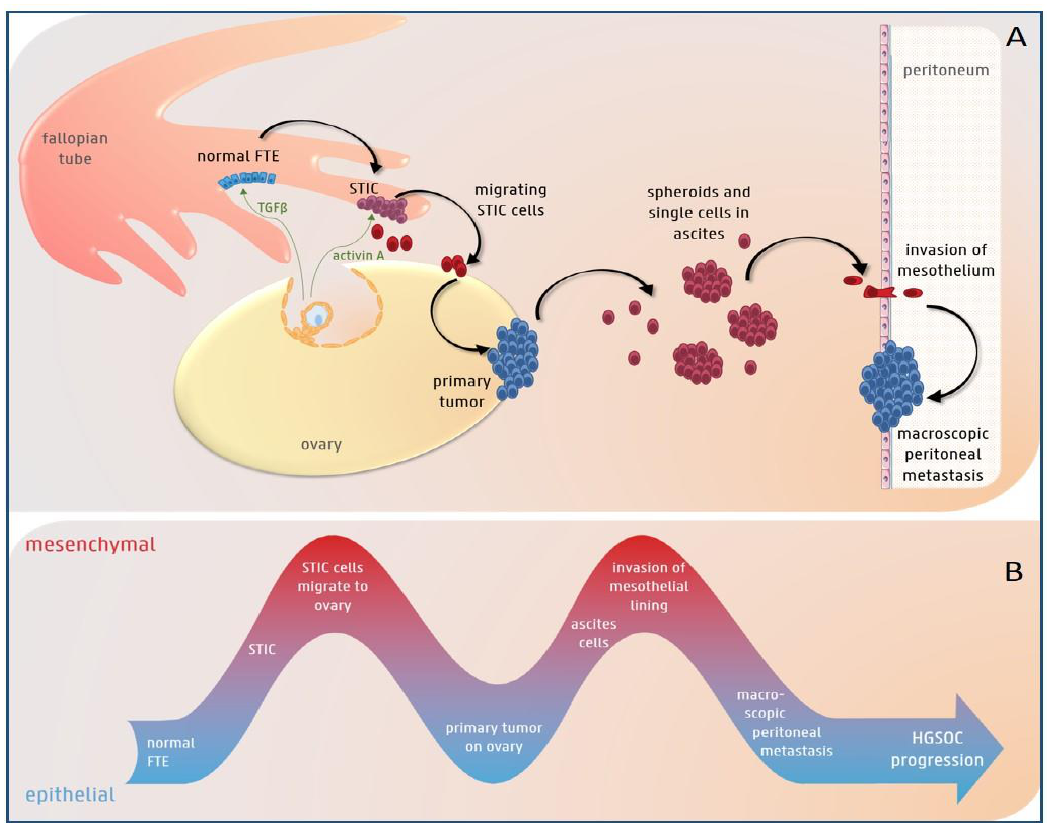
Figure 1. The potential role of epithelial-to-mesenchymal (EMT) plasticity during high-grade serous (HGS) ovarian cancer progression. ( A ) The color of the cells represents their EMT-state (blue = epithelial, purple = spectrum of epithelial/mesenchymal differentiation and red = mesenchymal). TGFβ present in follicular fluid, which is released during ovulation, can induce EMT in the normal fallopian tube epithelium (FTE). This can lead to the development of STIC (serous tubal intraepithelial carcinoma) lesions. Acitivin A, another component of the follicular fluid, stimulates migration of the STIC cells to the ovary, where they undergo mesenchymal-to-epithelial transition (MET) and form a primary tumor. In a later stage, cells exfoliate from the primary tumor and survive as single cells or spheroids in the ascites. Finally, they invade the mesothelium and again undergo MET to form macroscopic peritoneal or omental metastases. ( B ) EMT plasticity with EMT and MET alternately taking place during HGS ovarian cancer progression.